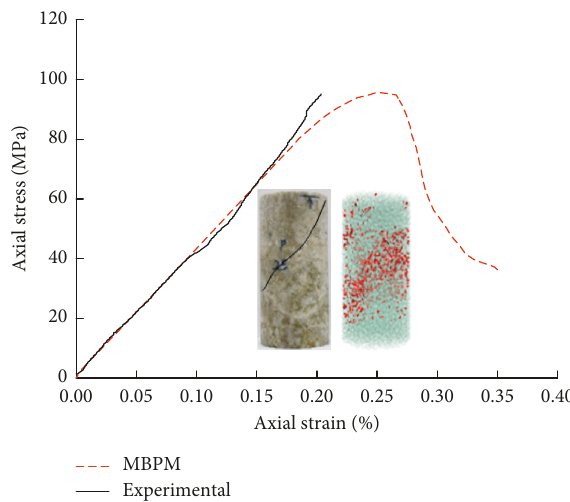
Figure 17: Comparison of experimental results and numerical results on the uniaxial compression test.